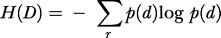
MuI between Neuronal Activity and Direction of MovementThe example shows a simulation of the activity of one cell during 64 movements to evenly spaced eight directions, presented in a random order (eight trials per direction). Each dot in the raster plots a and b describes the spike count of the cell in a specific trial. Without prior knowledge about the direction of movement (A), a large uncertainty exists about the responses of the neuron. However, ordering the trials according to the movement direction (B) reveals a large reduction in the uncertainty about the cell responses. The probability p(r,d) of observing a trial with direction d and spike count r is shown in (C); along with a specific conditional distribution p(r|d
0 = 90)
.
The entropy 

is a measure of the uncertainty about movement direction: H(D) = log(8) = 3 bits, in the case that all eight directions have equal probability to occur. The conditional entropy is defined as 

and describes the mean uncertainty about direction given the cell response. The MuI I(R;D) = H(D) − H(D|R)
measures the reduction in uncertainty about movement direction given the response of the cell. The MuI is symmetric, in the sense that it also measures the reduction in uncertainty about cell response given the direction of movement I(R;D) = H(D) − H(D|R)
. This relation is graphically depicted in (D).